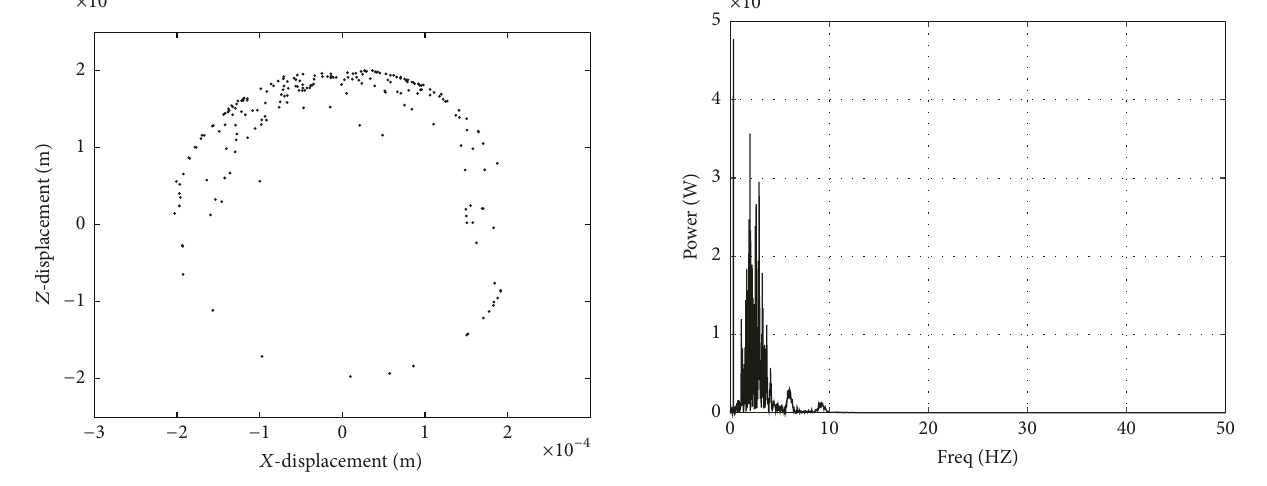
Figure 15: Power